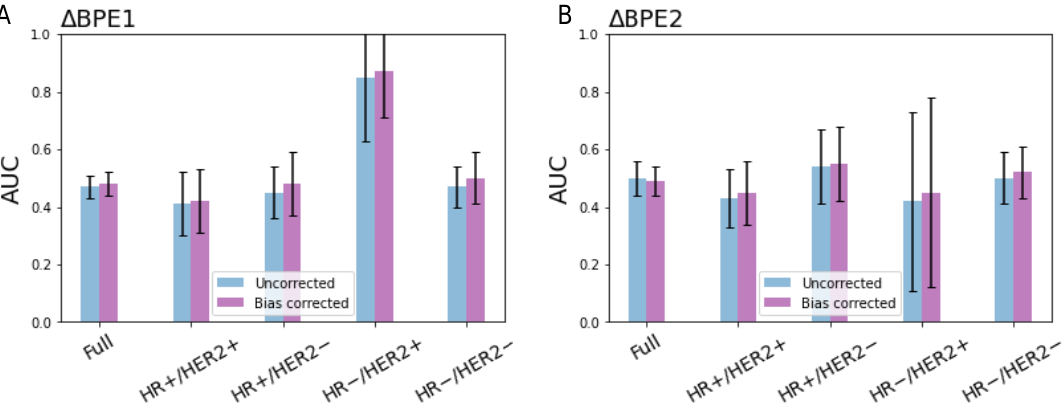
Figure 6. pCR prediction performance of BPE in the high-quality cohort ( n = 340): ( A ) percent change in BPE from T0 to T1 ( ∆ BPE1) and ( B ) percent change from T0 to T2 ( ∆ BPE2). Error bars show 1 standard